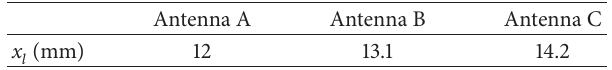
corresponding geometrical parameters of antennas A, B, and Table 1: The key geometrical parameters of antennas A, B, and C in Figure